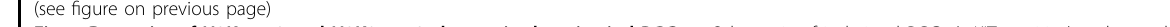
Fig. 1 Dynamics of H3K4me3 and H3K27me3 chromatin domains in hPGCs. a Schematic of isolating hPGCs (c-KIT – positive) and gonadal somatic cells (soma) (c-KIT – negative) used in ULI-NChIP-seq analysis. b Isolation of hPGCs (c-KIT – positive) and somatic cells (Soma, cKIT – negative) from a 11-week (Wk11) male embryonic gonads by FACS with cell-surface marker c-KIT (left). In each experiment, sample with a same treatment but without c-KIT staining (w/o c-KIT) was served as the negative control (right). c Barplot showing expression levels of selected marker genes in male hPGC (blue), female hPGC (red) samples and somatic cell samples of both sexes (male, light blue; female, pink). Expression levels are represented as log 2 (FPKM + 1). d Heatmaps showing the relationship between histone modi fi cation H3K4me3, H3K27me3 and chromatin accessibility on potential cis-elements de fi ned by promoters and DNase-seq peaks in early and late stage female hPGCs. e PCA of ChIP-seq pro fi les on human genome in samples including male (blue) and female (red) hPGCs, male (green) and female (orange) gonadal somatic cells from early (light color) stage to late (dark color) stage. The “ Circle ” indicates hPGC samples, and the “ Triangle ” indicates somatic cells. The “ Light ” -to- “ Dark ” color indicates biological samples isolated from early-to-late fetal germ cell developmental stages. f Boxplots showing comparison of H3K4me3 peak signi fi cance level between hPGCs and somatic cells at early and late stage in male and female. g Alluvial plot showing the global dynamics of (red) H3K4me3-, (blue) H3K27me3-, (green) bivalent-covered and (gray) unmarked promoters on human genome in hPGC samples of both sexes at indicated time points. h Boxplots showing the comparison of H3K4me3 and H3K27me3 pro fi les on low expression (L-exp), intermediate expression (M-exp) and high expression (H-exp) gene promoters in hPGC samples of both sexes at indicated stage. Pro fi les are calculated as ChIP-seq RPM. Genes were split equally into low, medium and high expression groups by ranks of expression in each period. i Barplot showing the proportion of 1 kb – 2 kb (light brown) and > 2 kb (orange) H3K4me3 domains in hPGC samples of both sexes at indicated stage. j Boxplots showing the comparison of expression levels between genes, whose promoters are covered by different length of H3K4me3 domains in hPGC samples of both sexes at indicated stage. Expression levels were represented as FPKM. For male, Wk8 – 10, Wk15 and Wk23 hPGC samples are represented as early, middle and late stage, respectively; for female, Wk8 – 10, Wk14 and Wk21 hPGC sample are represented as early, middle and late stage, respectively. Soma, gonadal somatic cells, F female, M male, w/ with, w/o without. Student ’ s t test is performed to examine the signi fi cant statistical difference between two groups of data in boxplots in ( f , h and j ). * P < 0.05, ** P < 0.01, *** P < 0.001, n.s. not signi fi